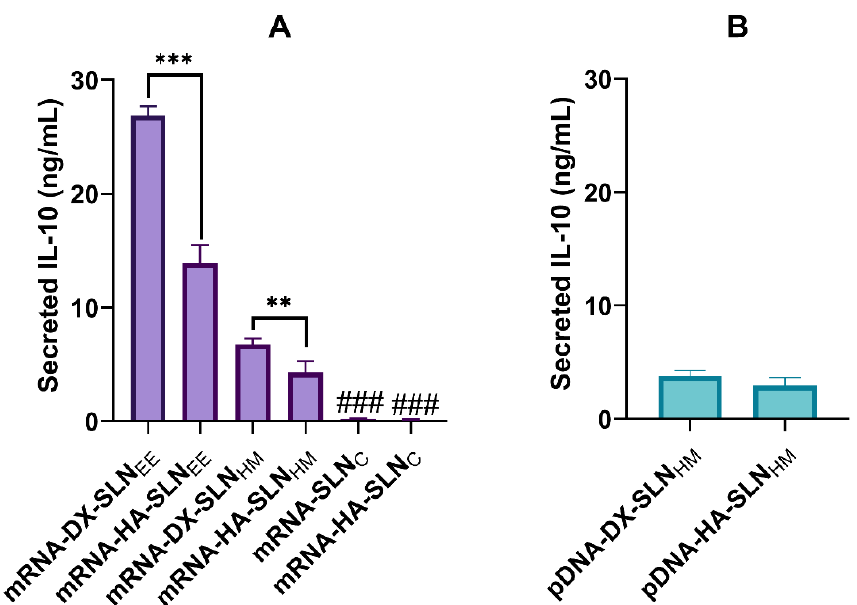
Figure 5. Levels of secreted IL-10 by HCE-2 cells after the administration of SLN-based vectors bearing IL-10 mRNA and pUNO1-hIL10 plasmid. ( A ) Concentration of secreted IL-10 48 h after the administration of mRNA-based vectors. ( B ) Concentration of secreted IL-10 72 h after the administration of pDNA-based vectors. ### p < 0.001 with respect to the mRNA-SLN EE and mRNA-SLN C formulations. ** p < 0.01 with respect to the other formulation. *** p < 0.001 with respect to the other formulation. DX: dextran; HA: hyaluronic acid; SLN EE : solid lipid nanoparticle prepared by emulsification-evaporation method. SLN HM : solid lipid nanoparticle prepared by hot-melt emulsification method. SLN C : solid lipid nanoparticle prepared by coacervation